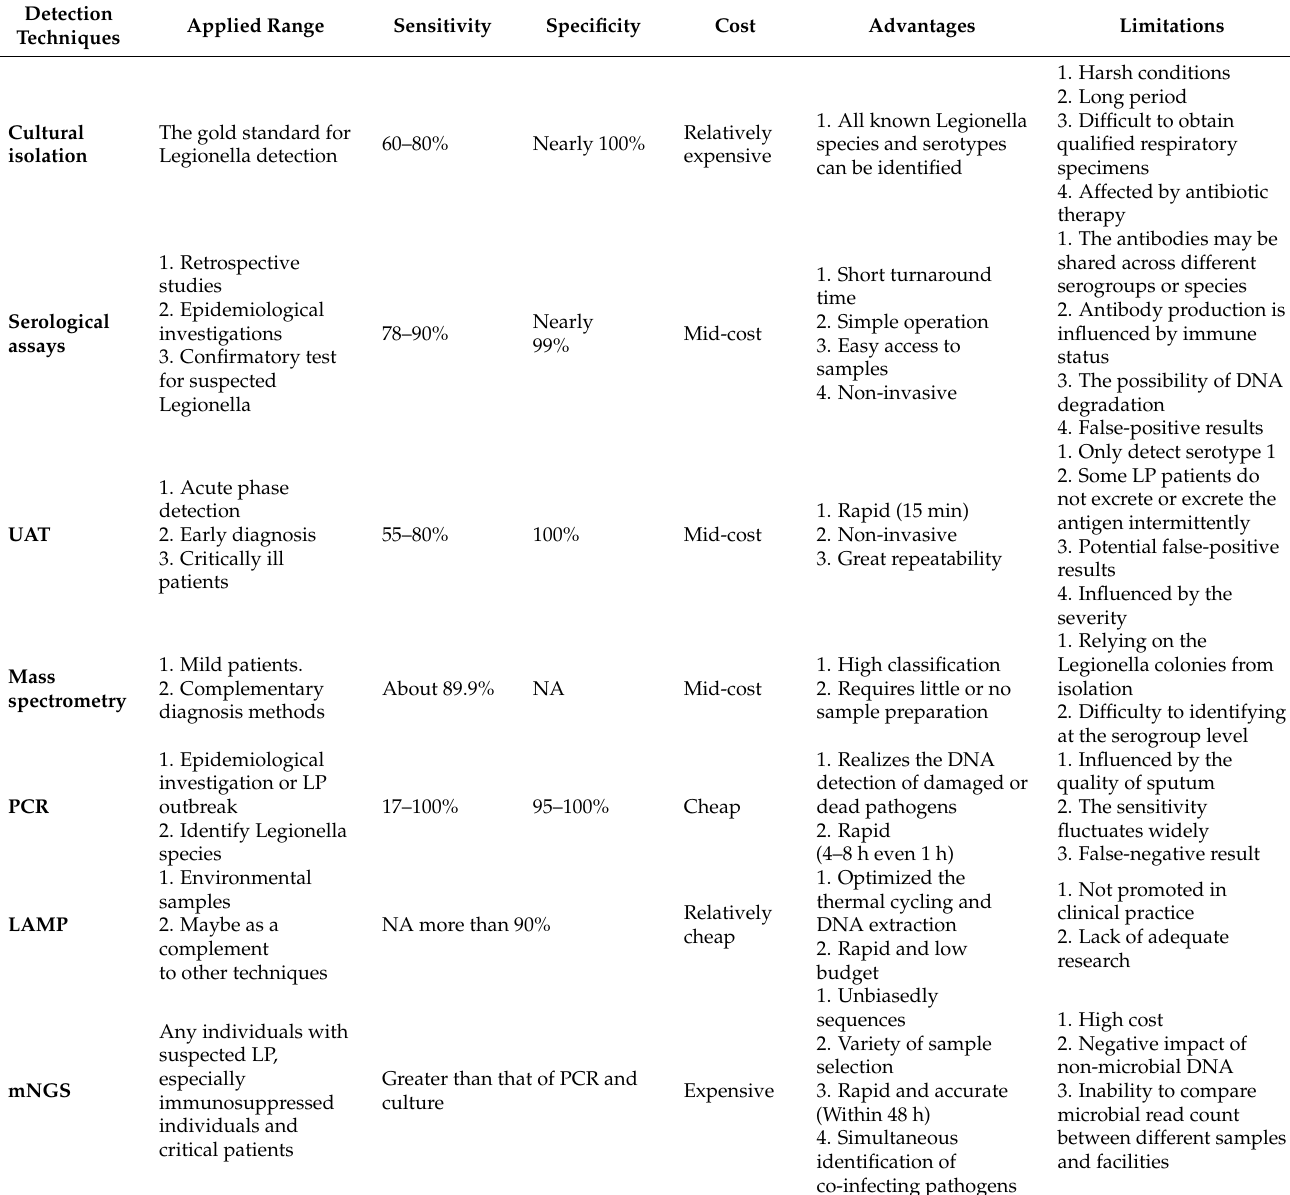
Table 1. Characteristics of various Legionella pathogenic detection